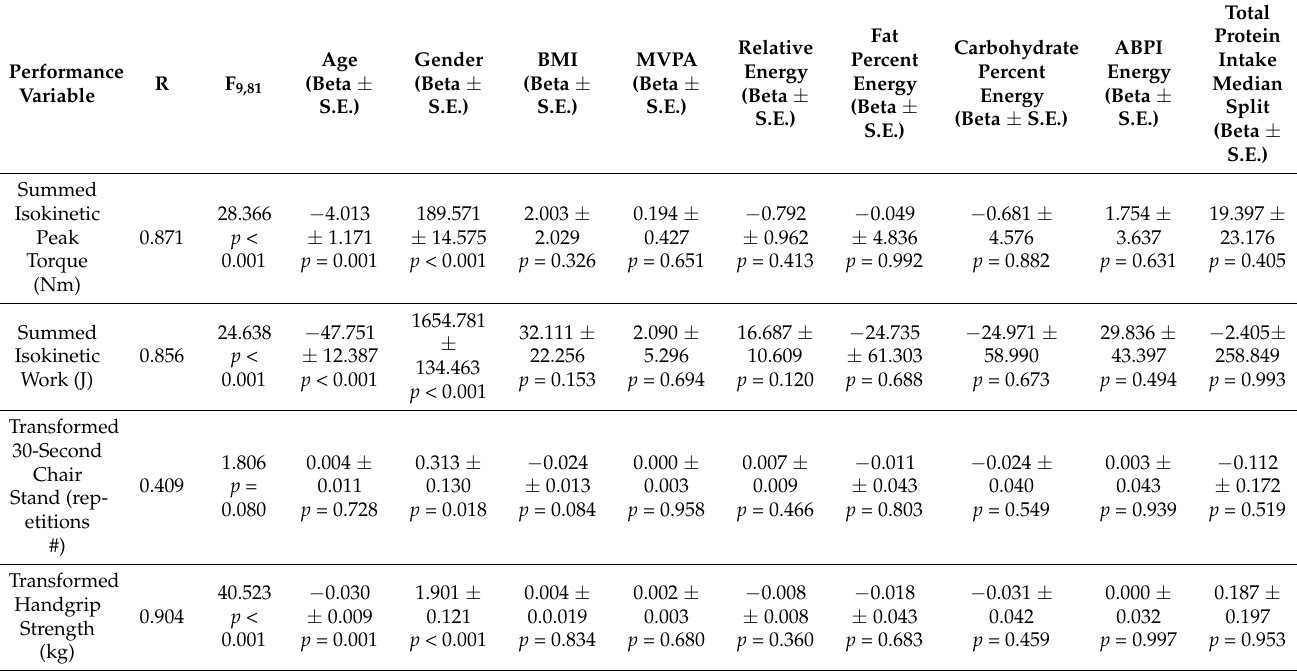
Table 9. Total protein intake and muscular performance in middle-aged men and